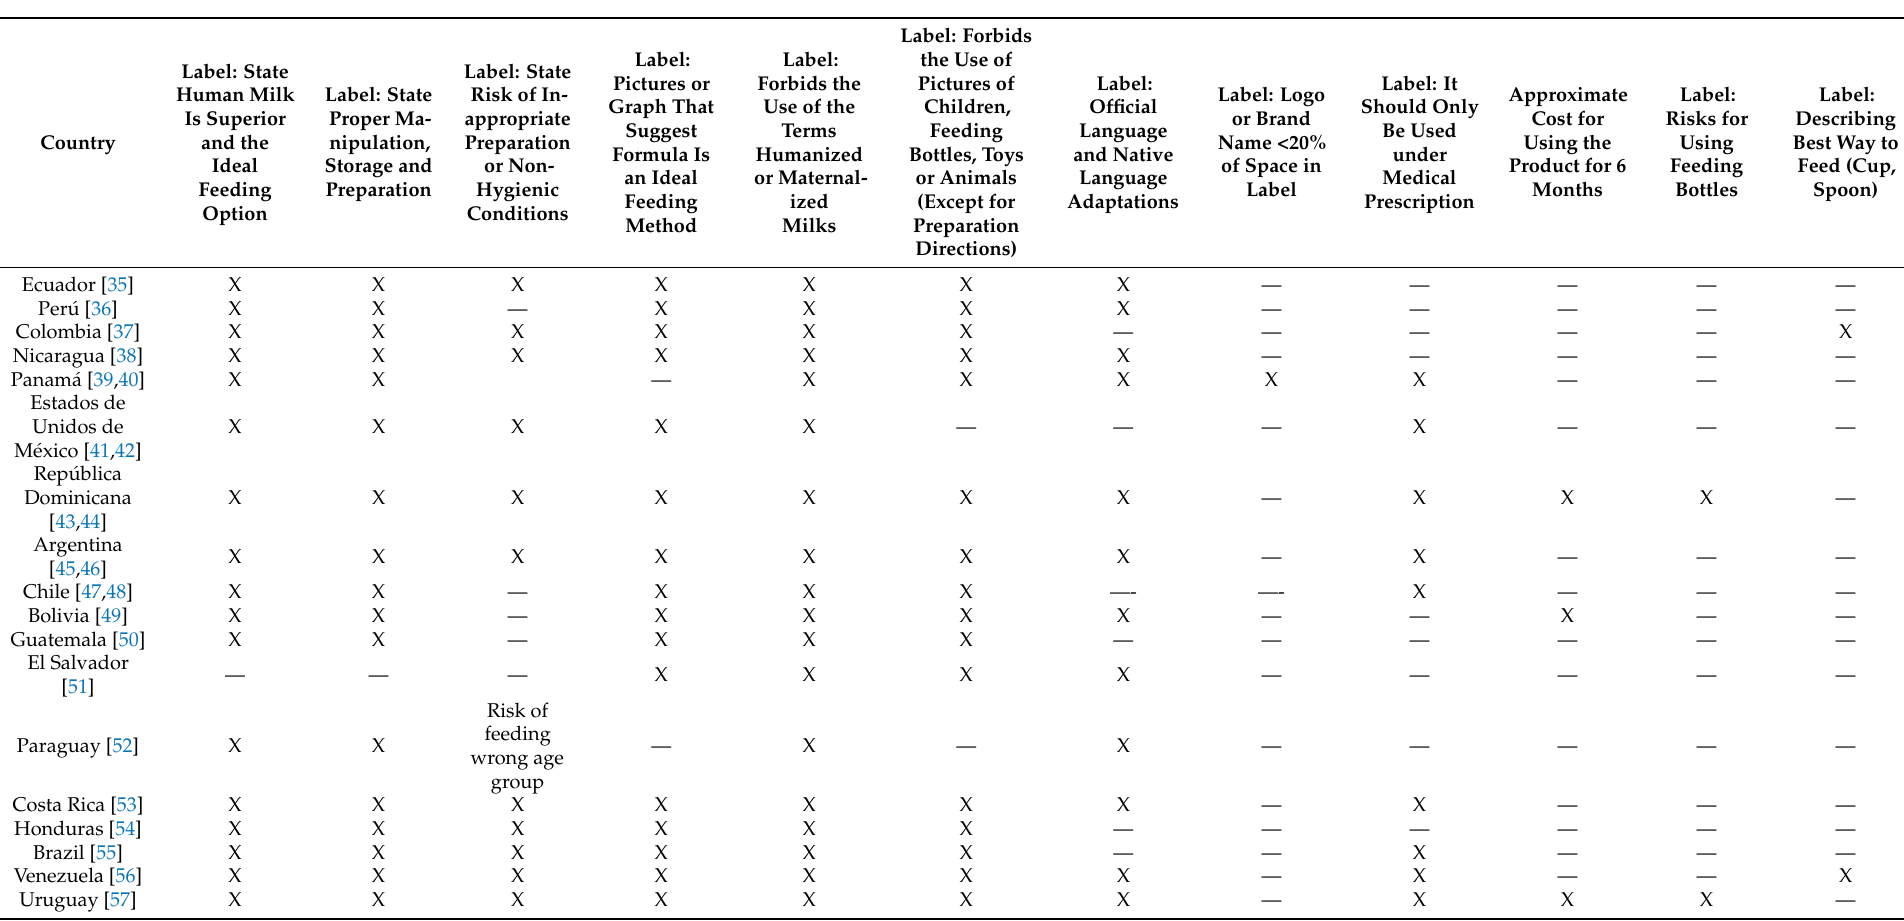
Table 7. Items related to BMS regulated in different Latin American